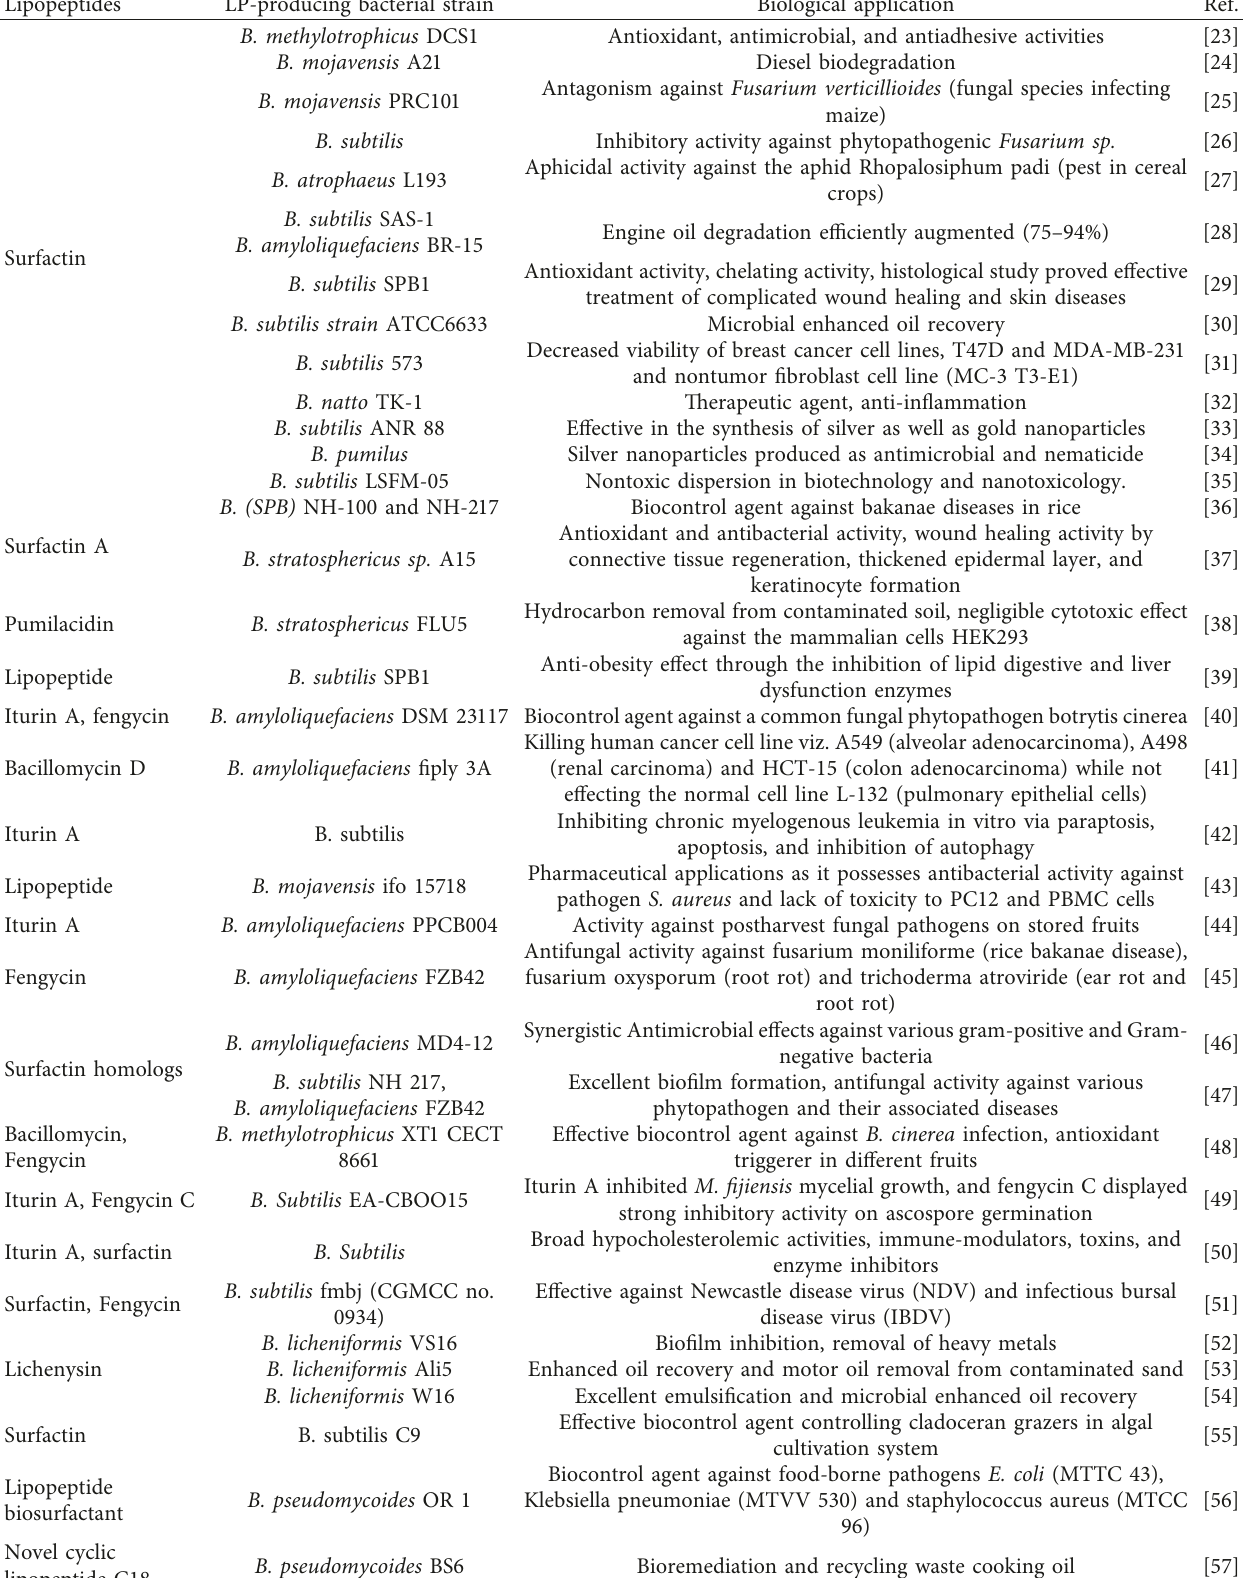
Table 1: Lipopeptide-producing strains and their